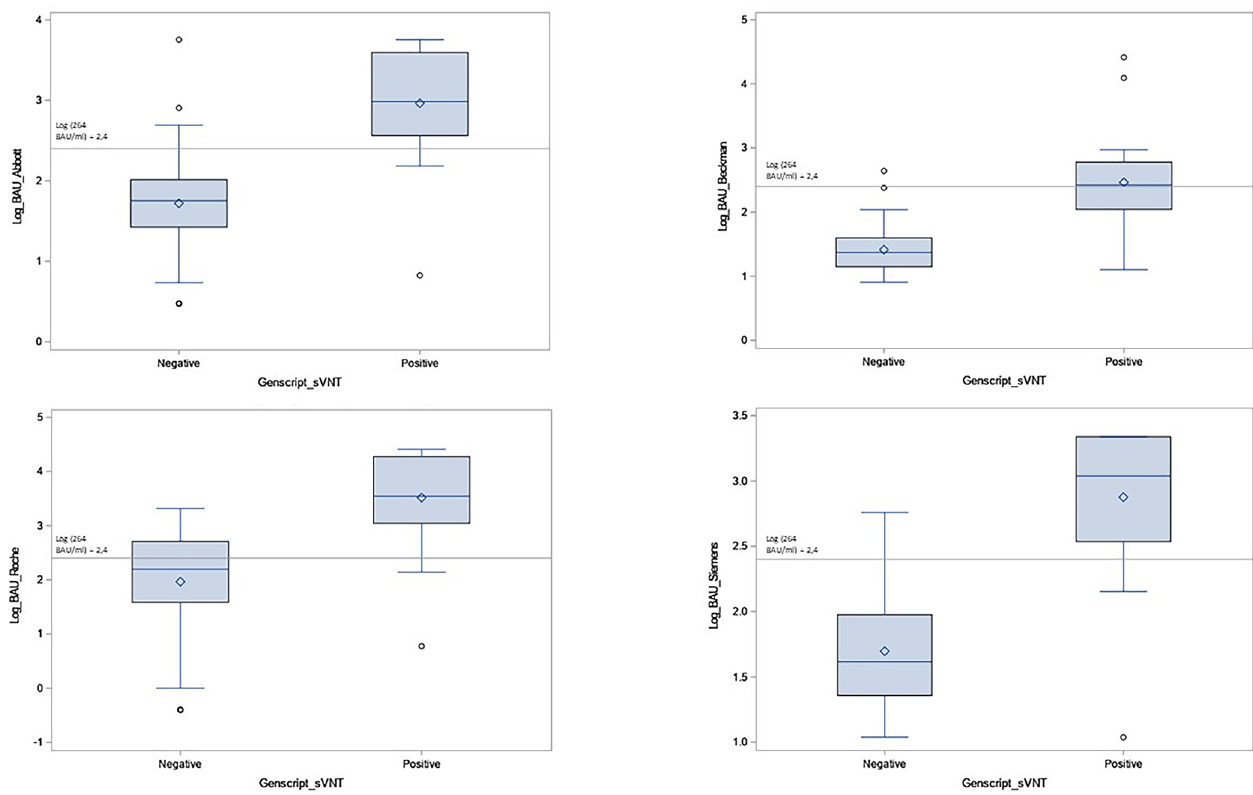
Fig 1. Boxplots for each antibody binding assay according to Genscript sVNT positive and negative results. Solid reference line represents 264 binding antibody units (BAU)/ml cutoff (2.4 Log). The Wilcoxon test for pairwise comparisons yielded P < 0.0001 for all comparisons. https://doi.org/10.1371/journal.pone.0281257.g001 cutoff of 264 BAU/ml for the Abbott and Beckman assays (148 and 48 BAU/ml, respectively). In contrast, the optimal cutoff was higher for the Roche assay (559 BAU/ml). For the Siemens assay, the optimal cutoff was within the same range as the reference cutoff (270 BAU/ml). When considering specific optimal cutoffs, agreement between each antibody binding assay and Genscript sVNT increased consistently from 0.03 units for the Siemens assay to 0.25 units Table 2. Agreement between antibody binding assays and Genscript sVNT positive and negative results according to the reference cutoff (264 BAU/ml). Assay